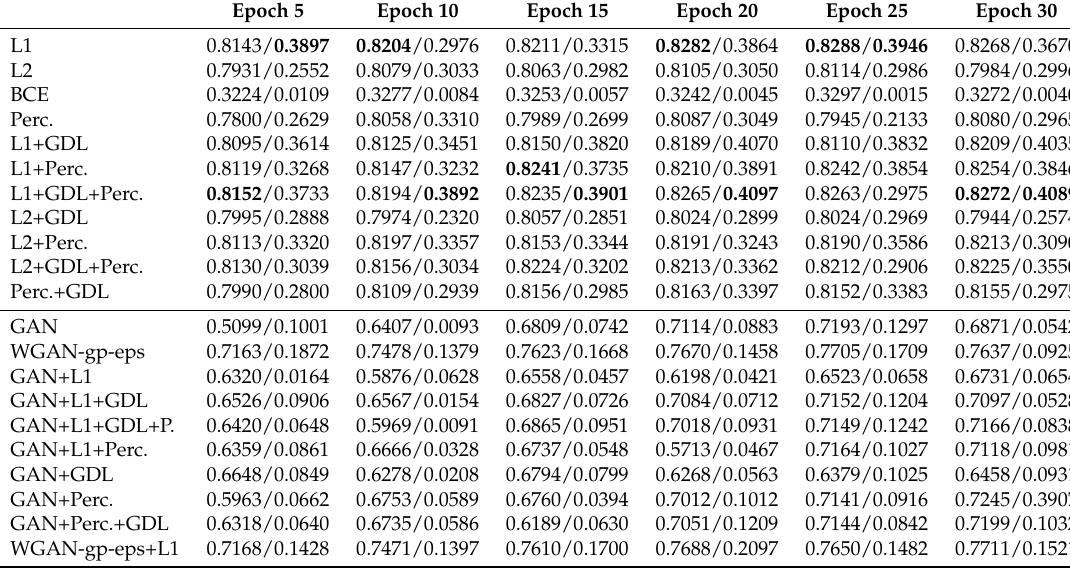
Table 2. Mean SSIM values for the next/10th frame prediction of the KITTI Tracking dataset. (Best results are bold, higher is better.) The values are obtained using the models that were trained for 5, 10, 15, 20, 25, and 30 epochs on the Cityscapes dataset. All models were trained to predict the next frame based on four past frames. More detailed lists for every evaluation dataset, including the MSE, PSNR, LPIPS, and FID values, are added in the supplementary